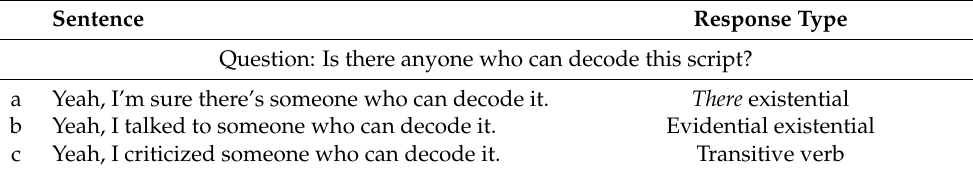
Table A1. Evidential existentiality norming study sample